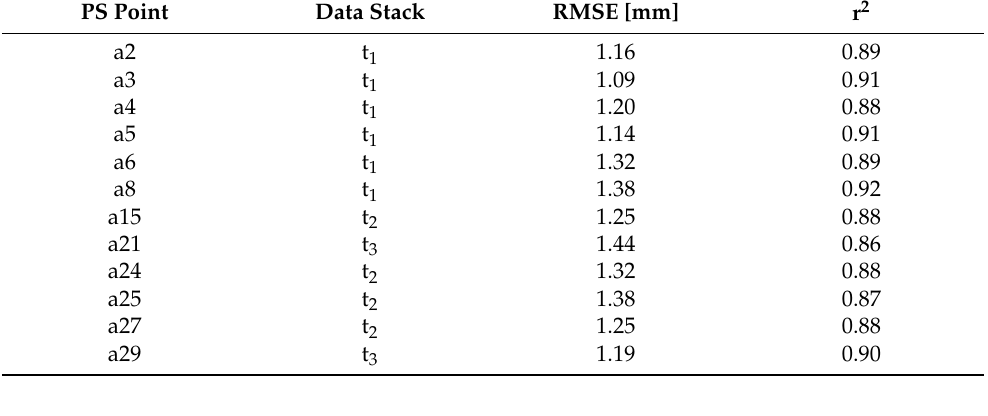
Table 4. List of PS points that are located on the dam crest. Additionally provided is their respective data stack and statistical values. RMSE and r 2 were computed using the PSI measurements and plumb measurements.